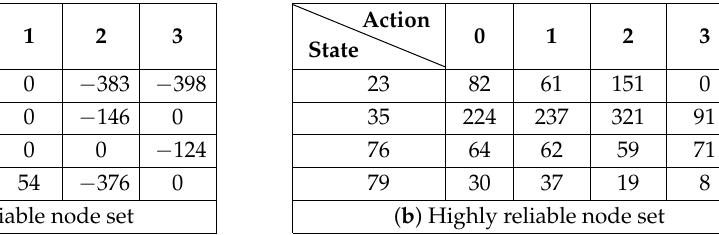
Figure 4. Transaction traverse procedure. Table 1. An example of a